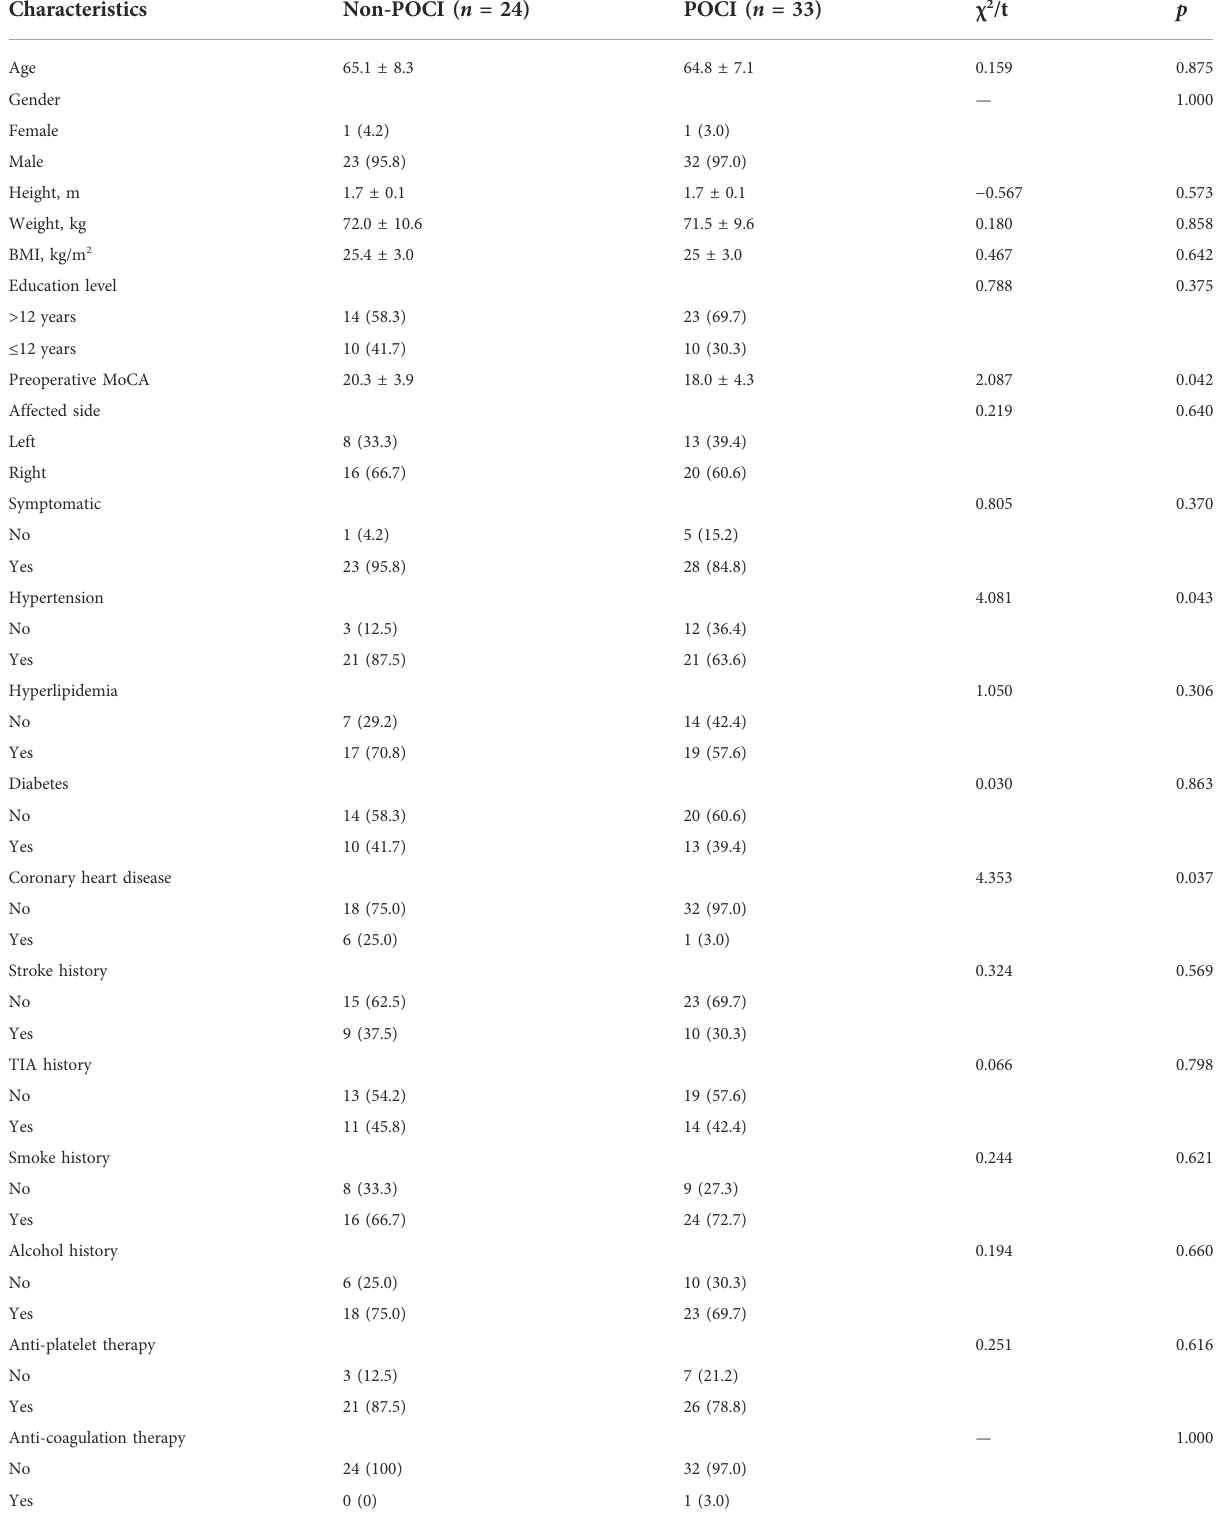
TABLE 1 Baseline characteristics of patients with and without